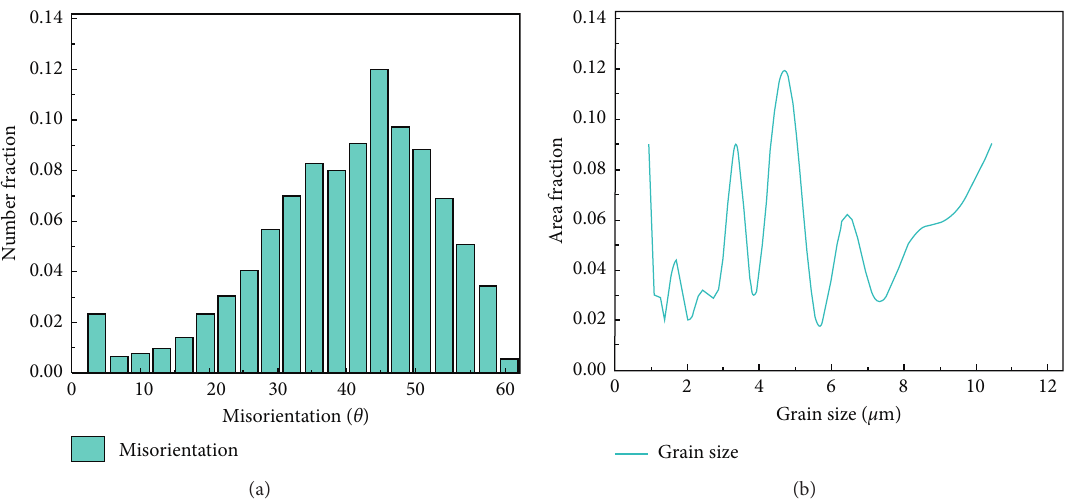
Figure 6: DCT at − 60 ° C and tempering at 350 ° C. (a) Misorientation histogram and (b) grain size